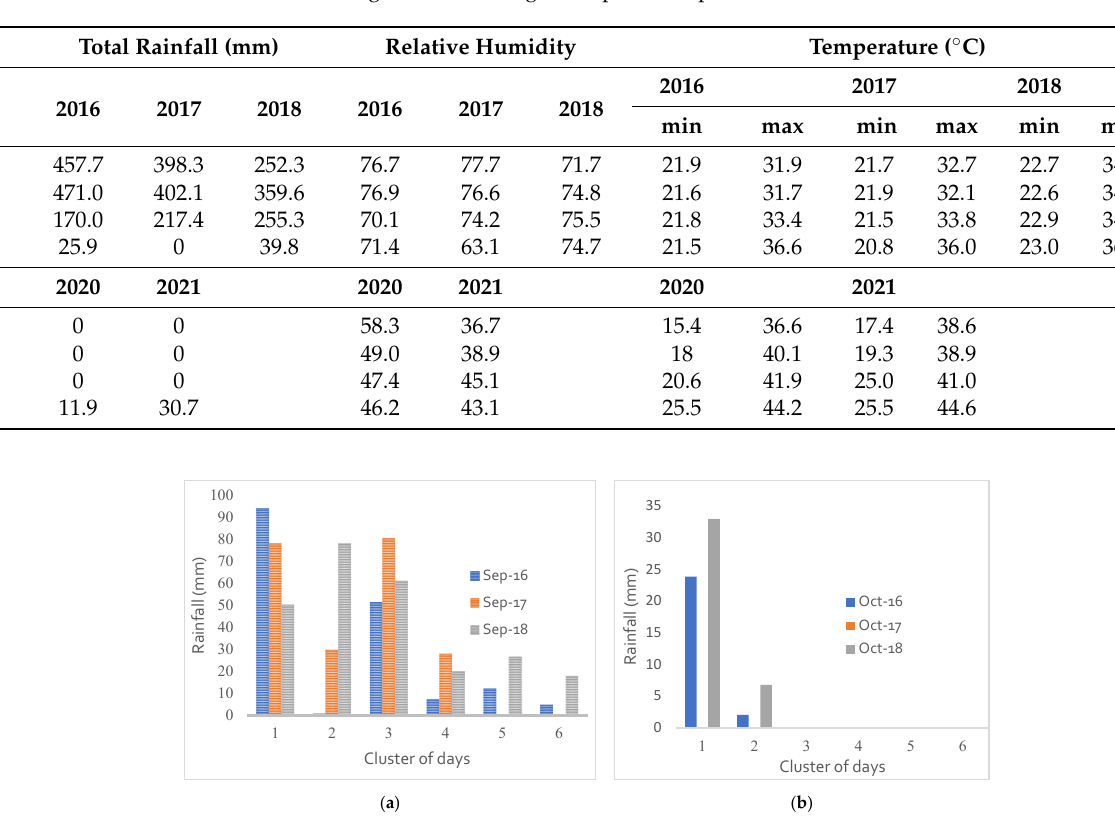
Figure 1. Total rainfall ( a ) September and ( b ) October with 5 days cluster in 2016, 2017, and 2018.